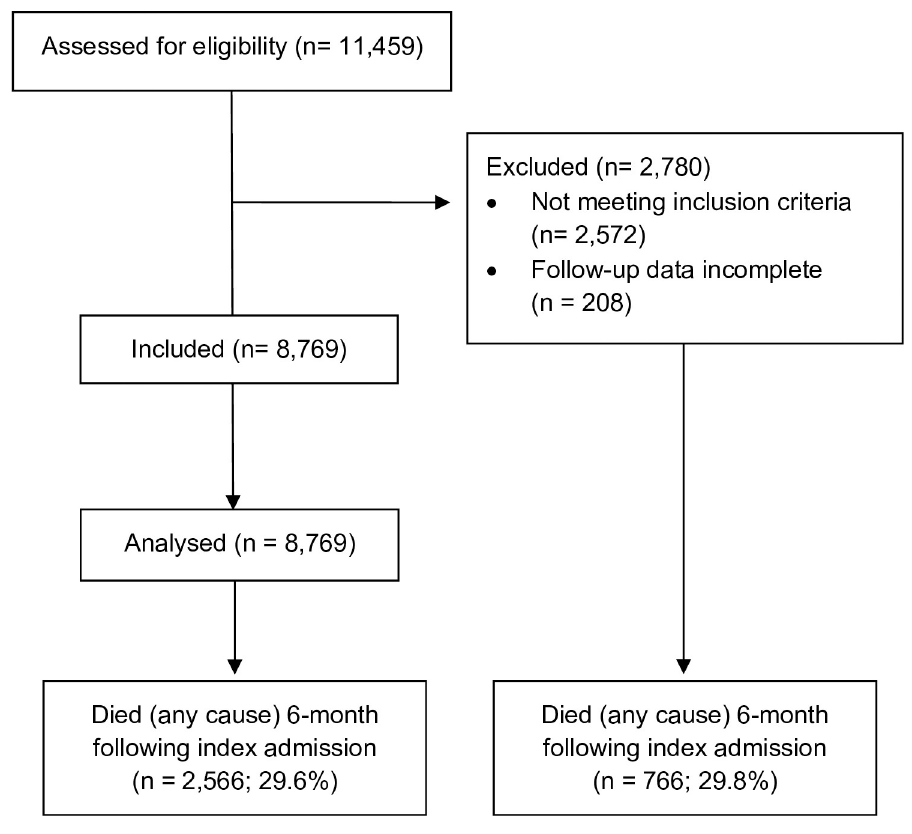
Fig 1. Patient flow